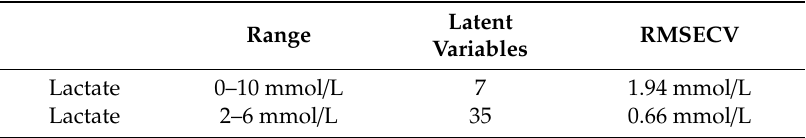
Table 1. Model parameters obtained from saliva